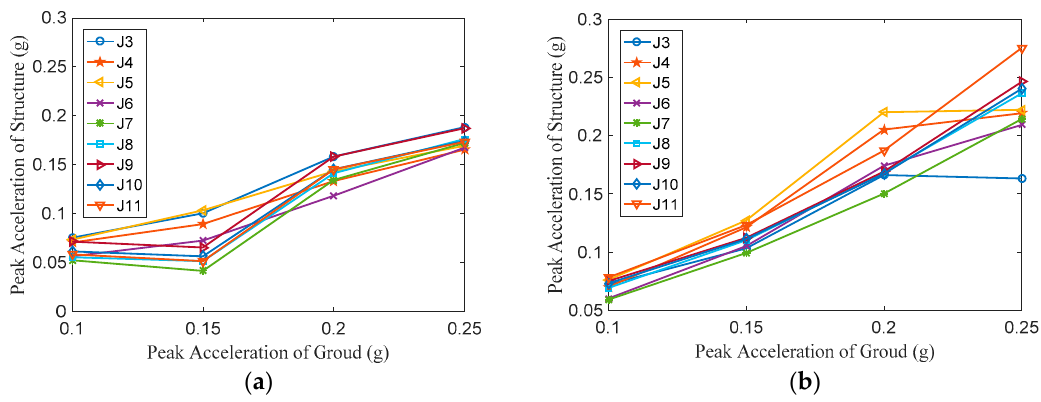
Figure 14. The peak value of the acceleration response for various seismic accelerations. ( a ) API and ( b ) RSN169_IMVPALL.